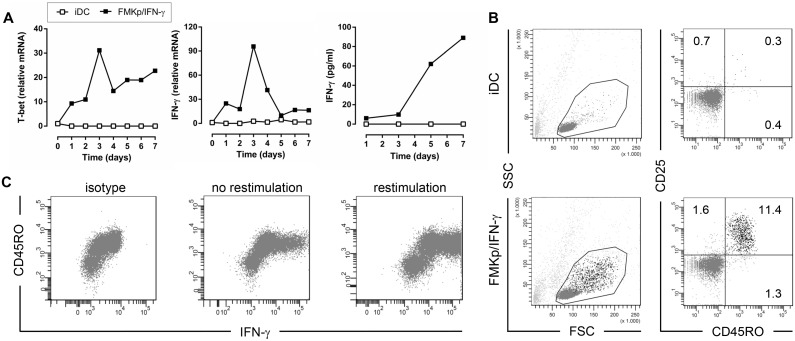
FMKp/IFN-γ-matured DC polarize a subpopulation of naive T cells into the Th1 lineage.iDC or FMKp/IFN-γ-matured DC were pulsed with PADRE for 1 h before the addition of autologous CD4+CD45RA+ T cells to the 7-day co-culture. (A) Expression of T-bet and IFN-γ and IFN-γ production of naive CD4+ T cells co-cultured with iDC (□) or FMKp/IFN-γ-matured DC (▪) are compared. CD3ε was used as housekeeping gene and the expression data were normalized to the relative mRNA content of naive T cells on day 0. IFN-γ production by naive T cells co-cultured with differently matured DC was determined in the supernatant of the co-culture on day 1, 3, 5 and 7 by CBA. Graphs are representative of 11 independent experiments. (B) On day 7, T cells were stained for expression of CD45RO and CD25 and analyzed by flow cytometry. Cells are gated in FSC/SSC on lymphocyte gate, excluding dead cells and doublets (light gray dots), and selected for CD4+ cells (dark gray and black dots). Percentages of CD45RO and CD25 positive populations are indicated in the plots. Dot plots are representative of 5 independent experiments. (C) On day 6 of the co-culture, GolgiPlug and GolgiStop were added to T cells with or without PMA/ionomycin restimulation. The next day, intracellular IFN-γ staining was performed and cells were analysed by flow cytometry. Representative dot plots of CD45RO and IFN-γ expression of CD4+ T cells co-cultured with FMKp/IFN-γ-matured DC are shown. Data are representative of 5 independent experiments.